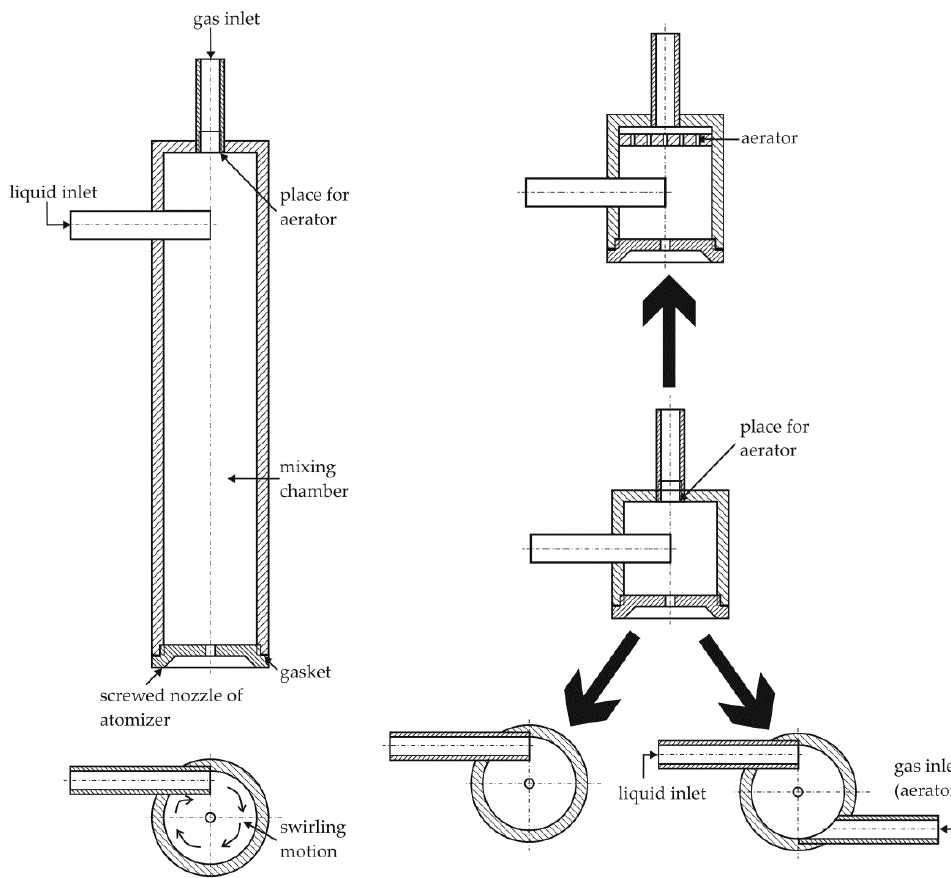
Figure 2. Exemplary schemes of effervescent atomizers of the type [20,44]: ( a ) inside-out, ( b ) out- side-in.